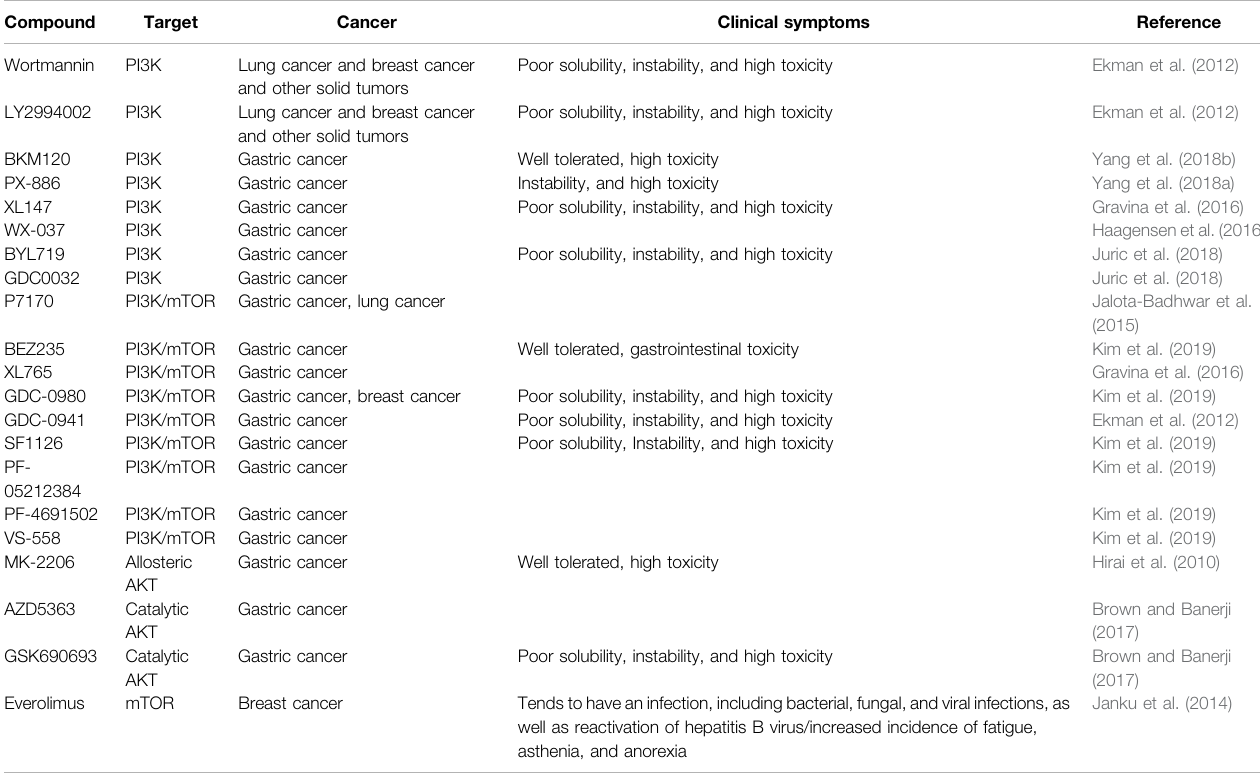
TABLE 3 | PI3K/AKT/mTOR inhibitors in cancers.